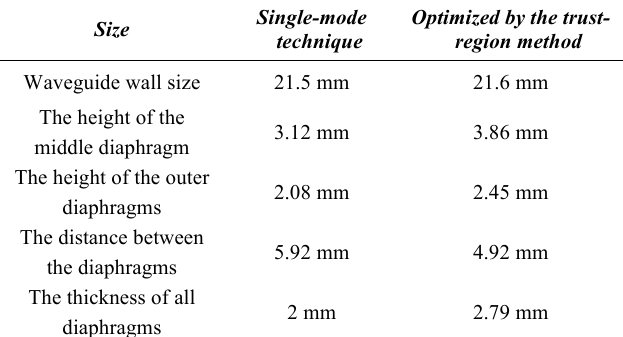
TABLE II. D IMENSIONS OF NON - OPTIMIZED AND OPTIMIZED WAVEGUIDE